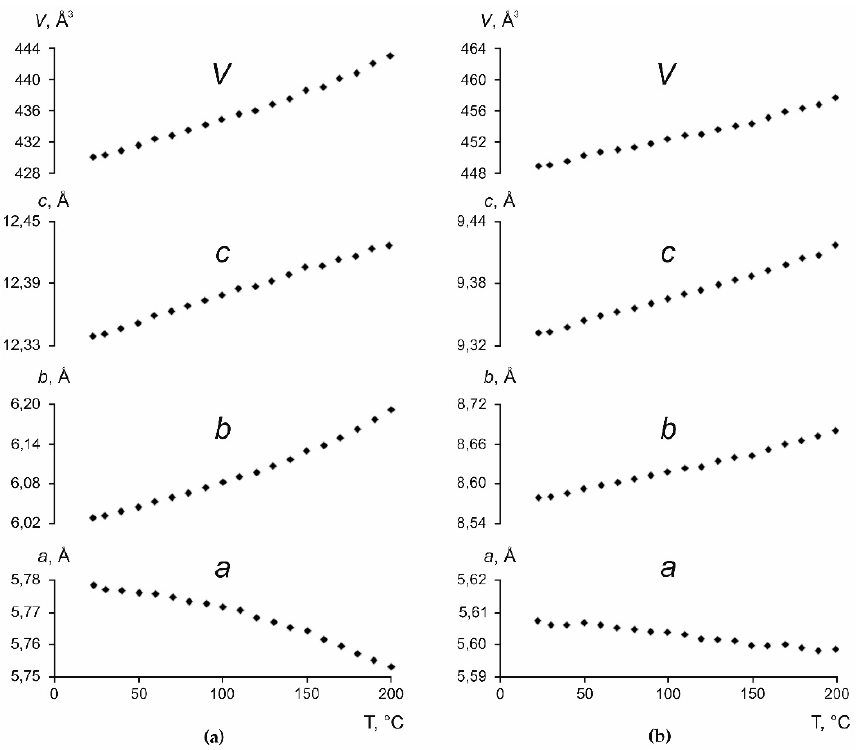
Figure 8. Changes in orthorhombic cell parameters a , b , and c (Å) and volume V (Å 3 ) versus the temperature for ( a ) L-ala and ( b ) L-ser.